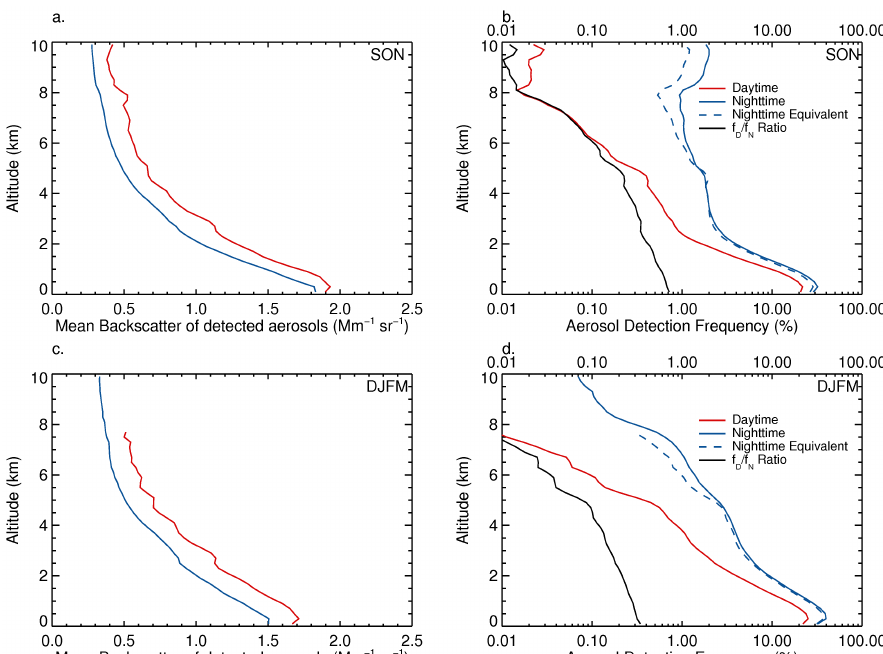
Fig. 2. Backscatter of detected aerosol layers (a, c) and vertical profiles of aerosol detection frequency (b, d) for 2006–2012 and latitude interval 61 ◦ –71 ◦ N. Daytime profiles are shown in red; nighttime profiles in blue. The top panels are for the months of September through November (SON), while the bottom panels are for December through March (DJFM). The black line in (b) and (d) shows the daytime-to- nighttime detection frequency ratio ( f D / f N ). The dashed blue line shows the nighttime-equivalent detection frequency.